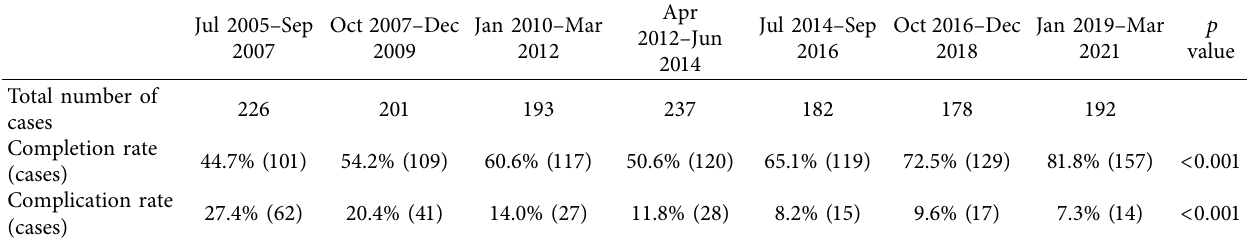
Figure 1: Time trend of different complications of phacoemulsification performed by resident surgeons. Iris: iris damage or prolapse ( p � 0 . 012), ACT: anterior capsulorhexis tear ( p < 0 . 001), PCR: posterior capsule tear without vitreous loss ( p � 0 . 585), Vlos: vitreous loss ( p � 0 . 076), PCR+Vlos ( p � 0 . 075) by Chi-squared test. Table 1: Time trend of completion and complication rates of phacoemulsification performed by residents.